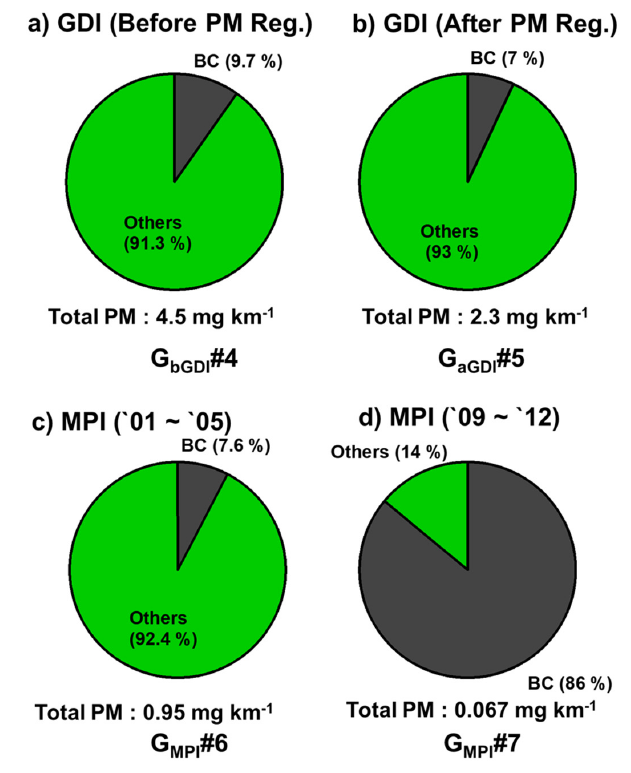
Figure 7. BC / PM ratio of gasoline vehicles. ( a ) GDI vehicle before PM regulation. ( b ) GDI vehicle after PM regulation. ( c ) MPI vehicle made between 2001–2005. ( d ) MPI vehicle made between 2009–2012.